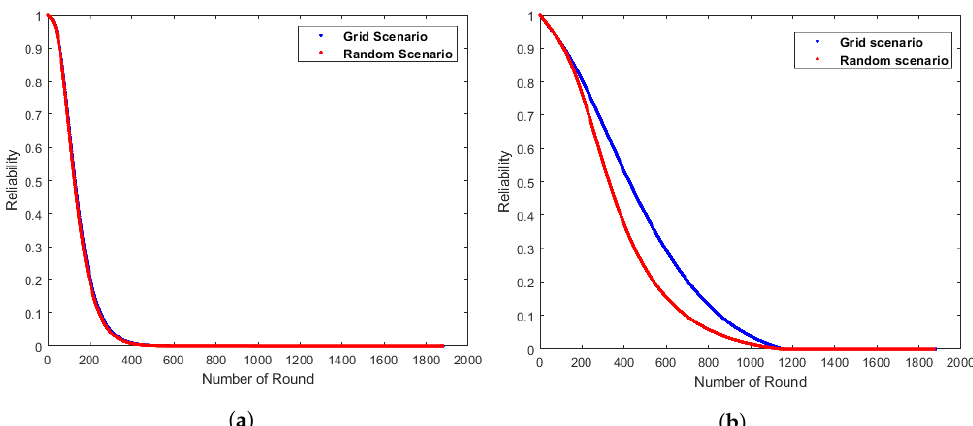
Figure 21. Multi-chain multi-hop stationary CHs energy reliability-based proposed RBD: